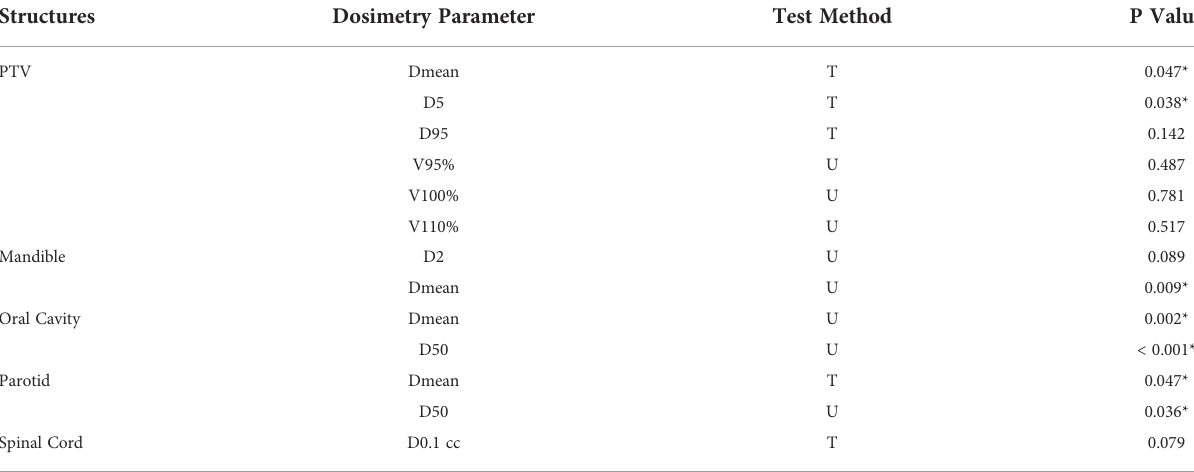
TABLE 3 The difference signi fi cance test between the absolute dose errors of sCT_M and CT_M images and the absolute errors of sCT_MF and CT_MF images for the PTV and OARs. Structures Dosimetry